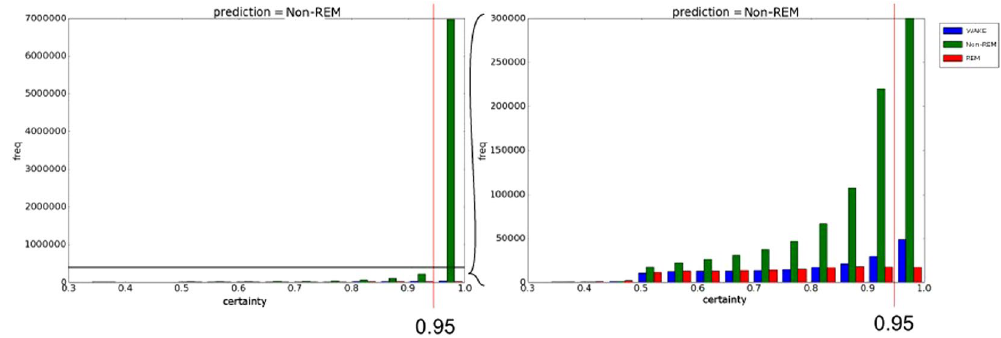
Figure 4. Histogram showing distribution of stages labeled as